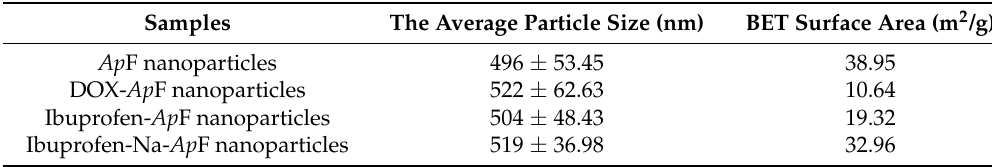
Table 1. The average size and BET surface area of Ap F nanoparticles and drug- Ap F nanoparticles. Samples